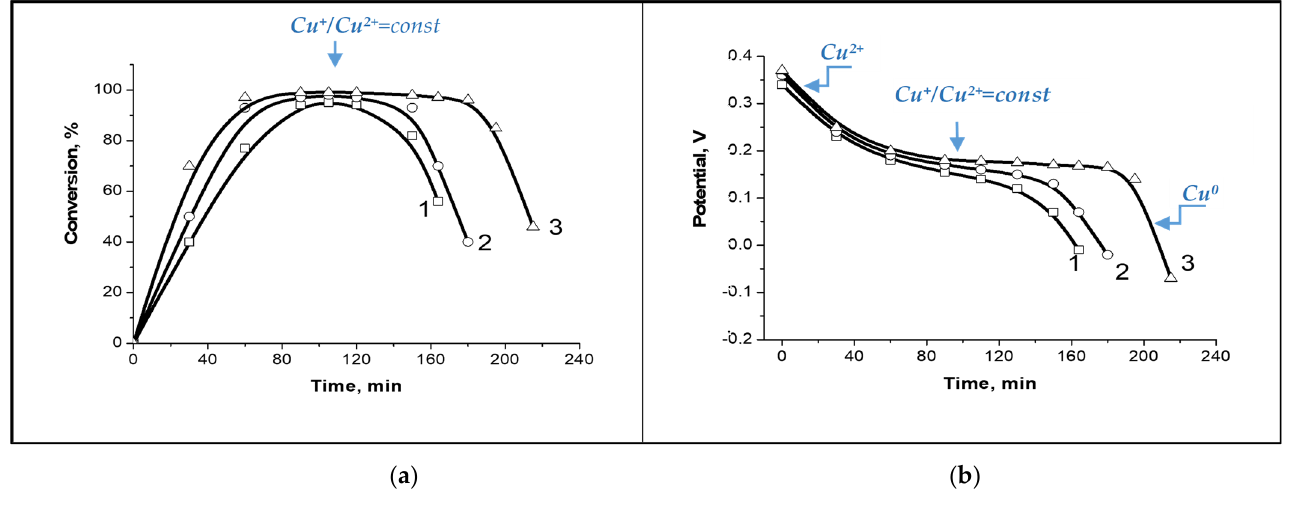
Figure 8. Conversion ( a ) and potentiometric ( b ) curves of PH 3 absorption at 40 °C, V PH3 = 40 mL/min, PH 3 —493 mg/m 3 , composition, mol/L: NH 4 OH—0.65, CuSO 4— 0.02 (curve 1), 0.04 (curve 2), and 0.06 (curve 3).